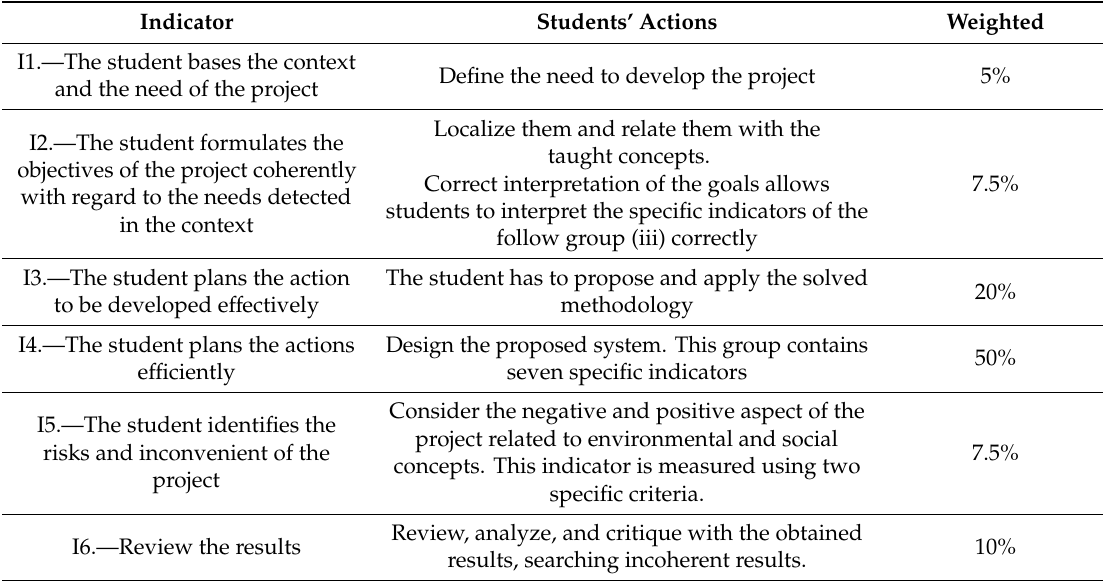
Table 1. Definition of weighted in the di ff erent